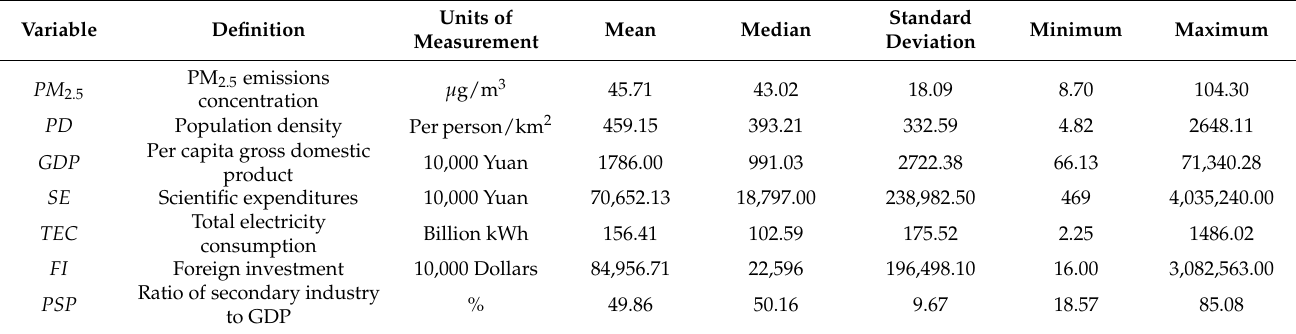
Table 1. Data sources and definition of variables and descriptive